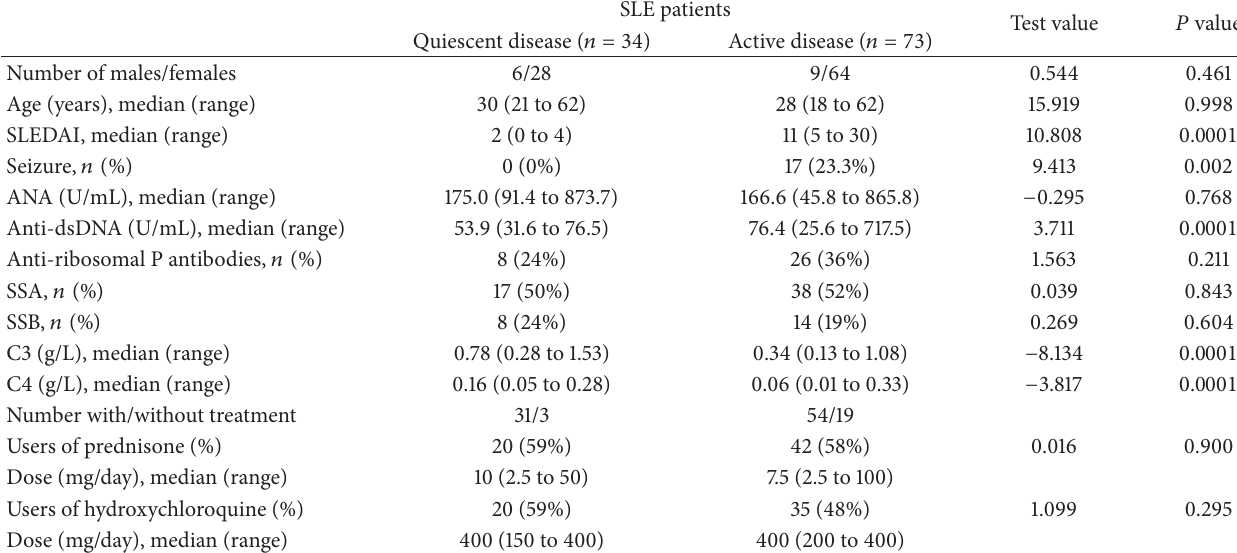
Table 1: Comparison of clinical characteristics between quiescent and active SLE patients.